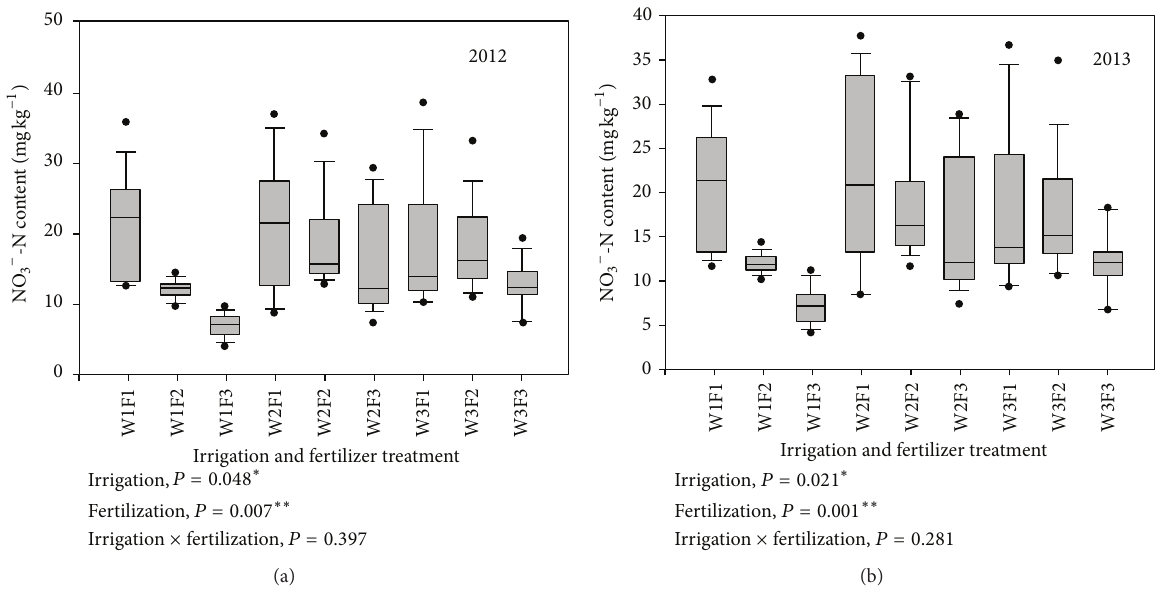
Figure 2: The average soil NO 3− -N contents of 0–60 cm soil profile after harvesting. W1: 100% ET 0 , W2: 75% ET 0 , and W3: 50% ET 0 ; F1: N240–P 2 O 5 120–K 2 O150 kg hm −2 ; F2: N180–P 2 O 5 90–K 2 O112.5 kghm −2 ; and F3: N120–P 2 O 5 60–K 2 O75 kg hm −2